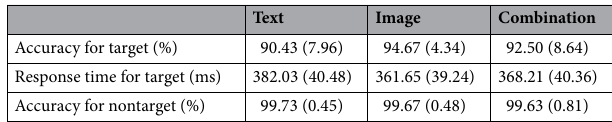
Table 2. Accuracy and response time in the Go/No-go task (SD).